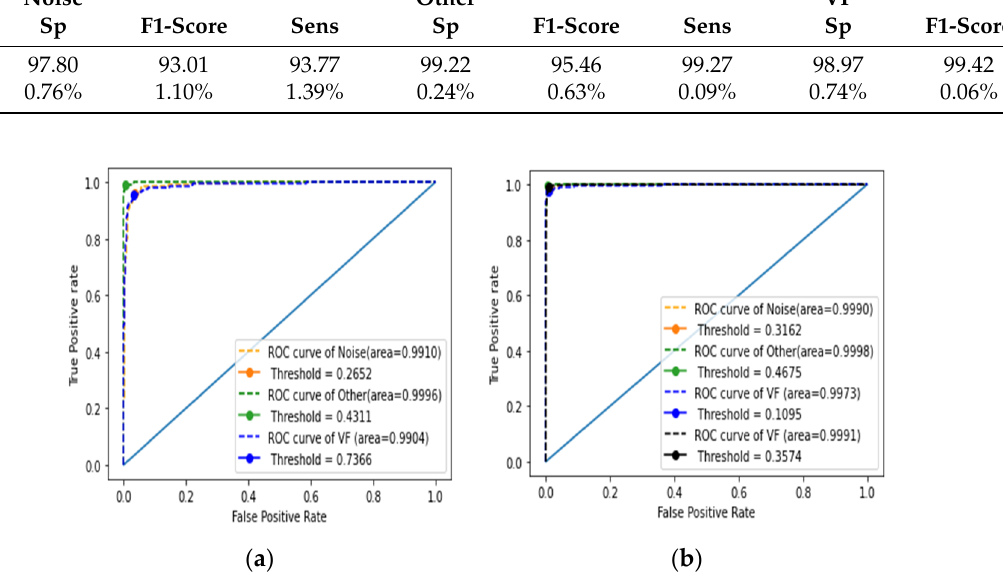
Figure 5. Performance metrics using the ROC curves: ( a ) first stage; ( b ) second stage. Table 9. Performance of the first stage cross-validation test using the AUC of the ROC